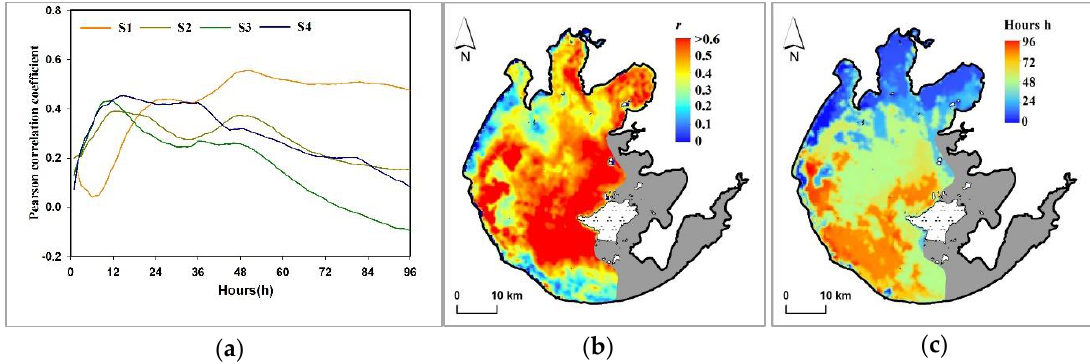
Figure 14. ( a ) Pearson correlation coefficients ( r ) between the OLCI-derived K d (490) and the mean wind speed for different hours (h = 1, 2, 3, . . . , 96 h) before the satellite image acquisition time at 4 virtual stations; ( b ) distribution of the maximum Pearson correlation coefficients ( r ); ( c ) distribution of hours corresponding to the maximum Pearson correlation coefficients.